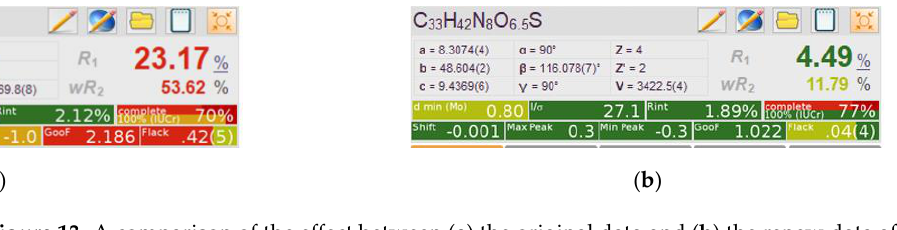
Figure 13. A comparison of the effect between ( a ) the original data and ( b ) the renew data after CIR assistance for a hard-solving crystal example.